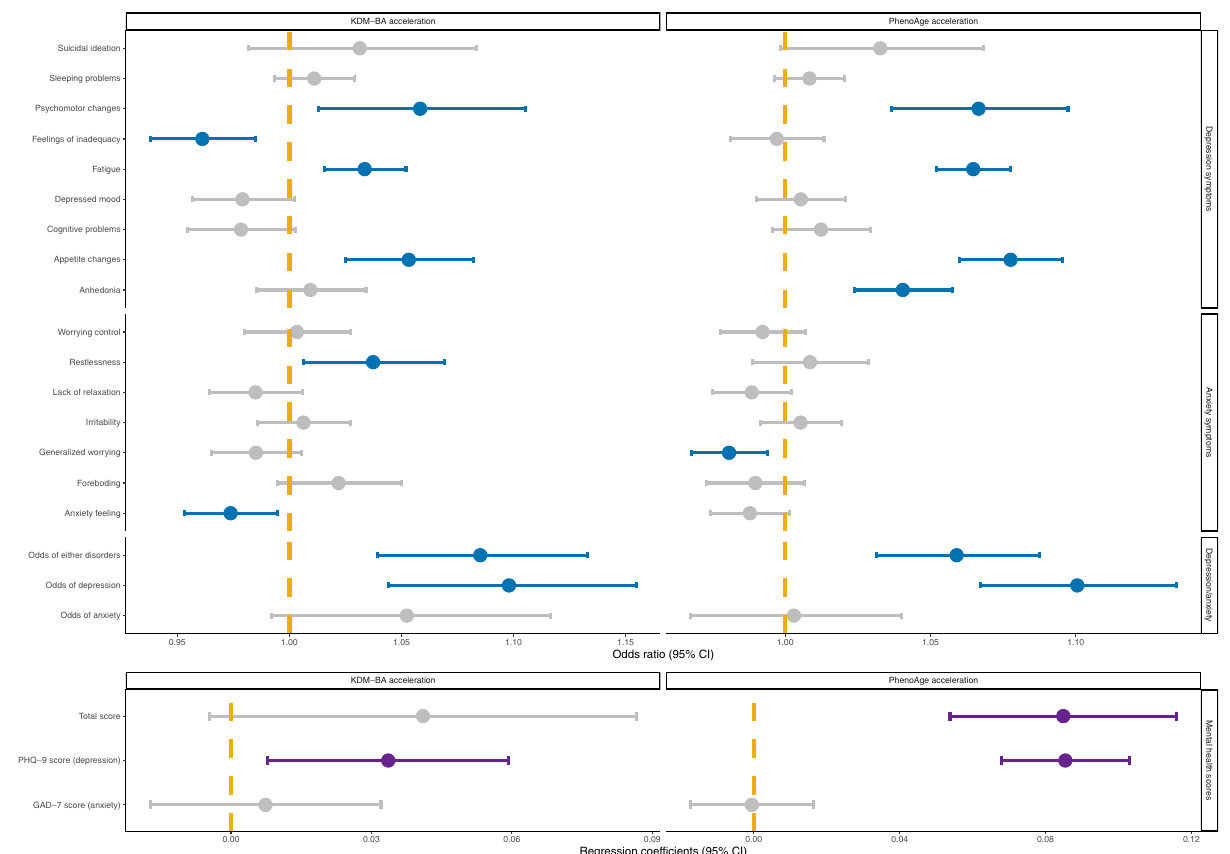
Fig. 3 | Prospective associations of baseline biological age accelerations with odds of depression/anxiety symptoms and mental health scores at follow-up surveyforthe124,976participantsthatwerefreeofdepressionandanxietyat baselinewith availableonlinemental health survey data. Dots (centersof error bars): Point estimate; Error bar: 95% con fi dence limits; Dash line: Reference line; Upper partisthe odds ratios of logisticregression, lower part isthe coef fi cients of linearregression;Dotsanderrorbarscoloredinblue(foroddsratios)orpurple(for coef fi cients) are statistically signi fi cant (unadjusted p -values<0.05), otherwise are